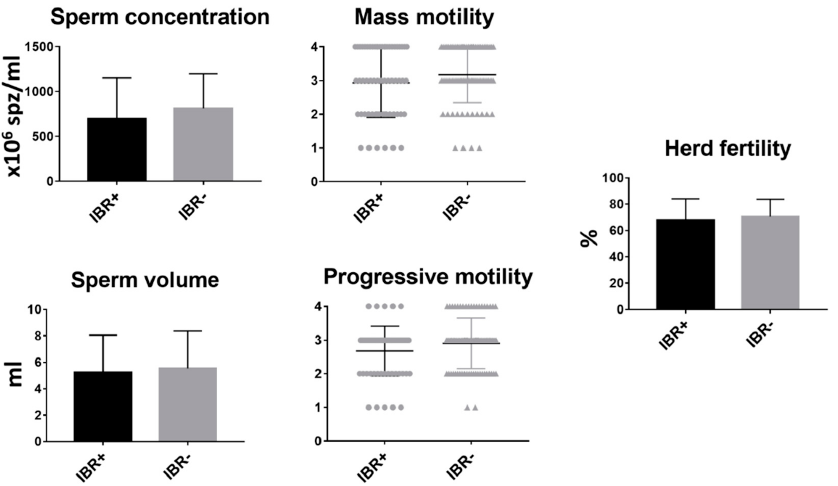
Figure 2. Analysis of sperm parameters and fertility between infectious bovine rhinotracheitis (IBR)-positive and IBR- negative bulls. Mean and SEM of seminal parameters and herd fertility of IBR-positive and IBR-negative bulls. * indicates statistically significant differences, t-test ( p < 0.05).